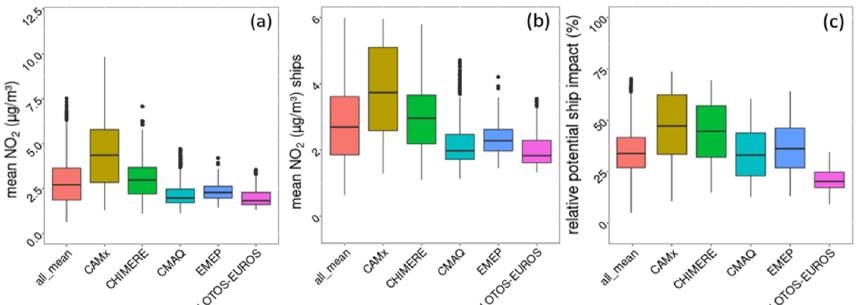
Figure 3. Annual mean for all grid cells in the whole model domain. (a) Mean NO 2 for all emission sectors (base case); (b) mean NO 2 for shipping only; (c) relative potential ship impact on total NO 2 concentration. All_mean is the mean value of all models, with a median of